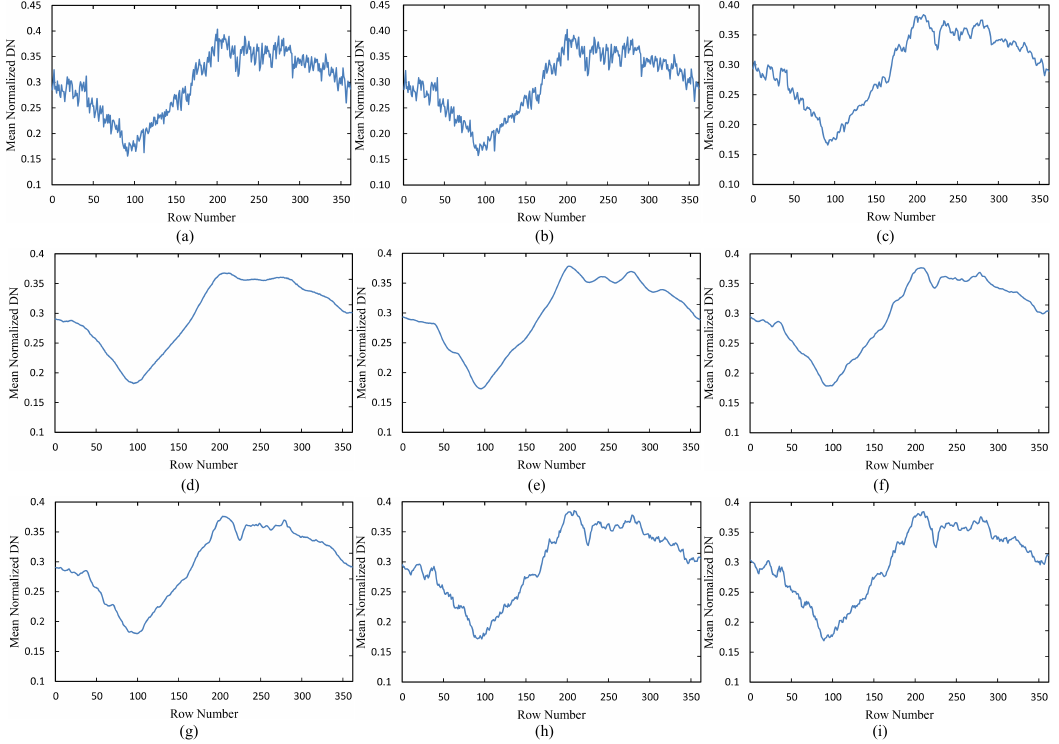
Figure 25. Mean cross-track profiles of Terra MODIS data R4. ( a ) original; ( b ) BM3D; ( c ) SNRCNN; ( d ) GF-based; ( e ) WAFT; ( f ) UV; ( g ) HUTV; ( h ) SUV; ( i )